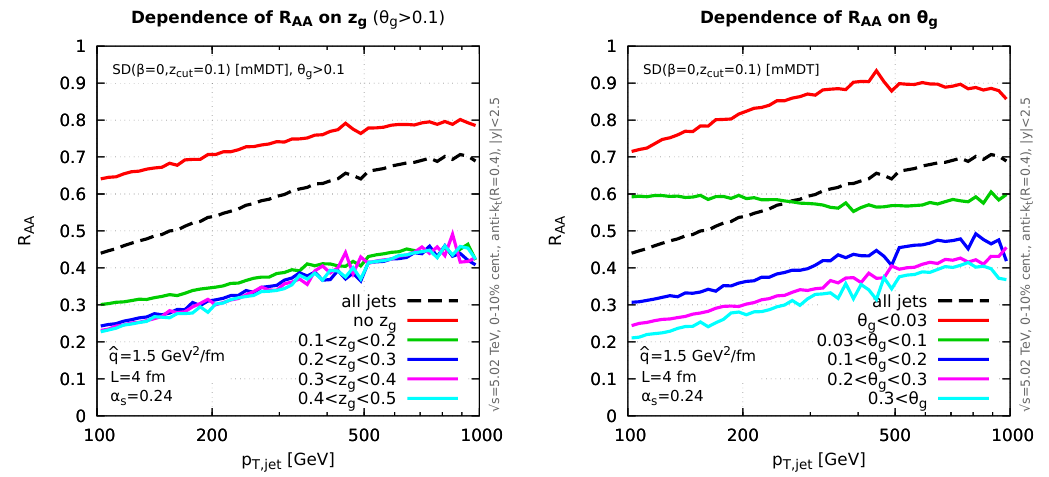
Figure 23 . Our MC results for the jet R AA as a function of p T; jet are shown in bins of z g (left (cid:12)gure) and in bins of (cid:18) g (right (cid:12)gure). The inclusive (all- z g , respectively all- (cid:18) g ) results are shown with dashed